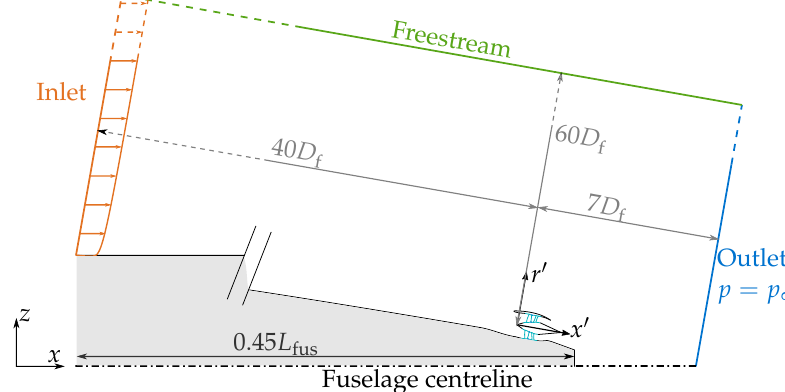
Figure 2. Computational domain and boundary